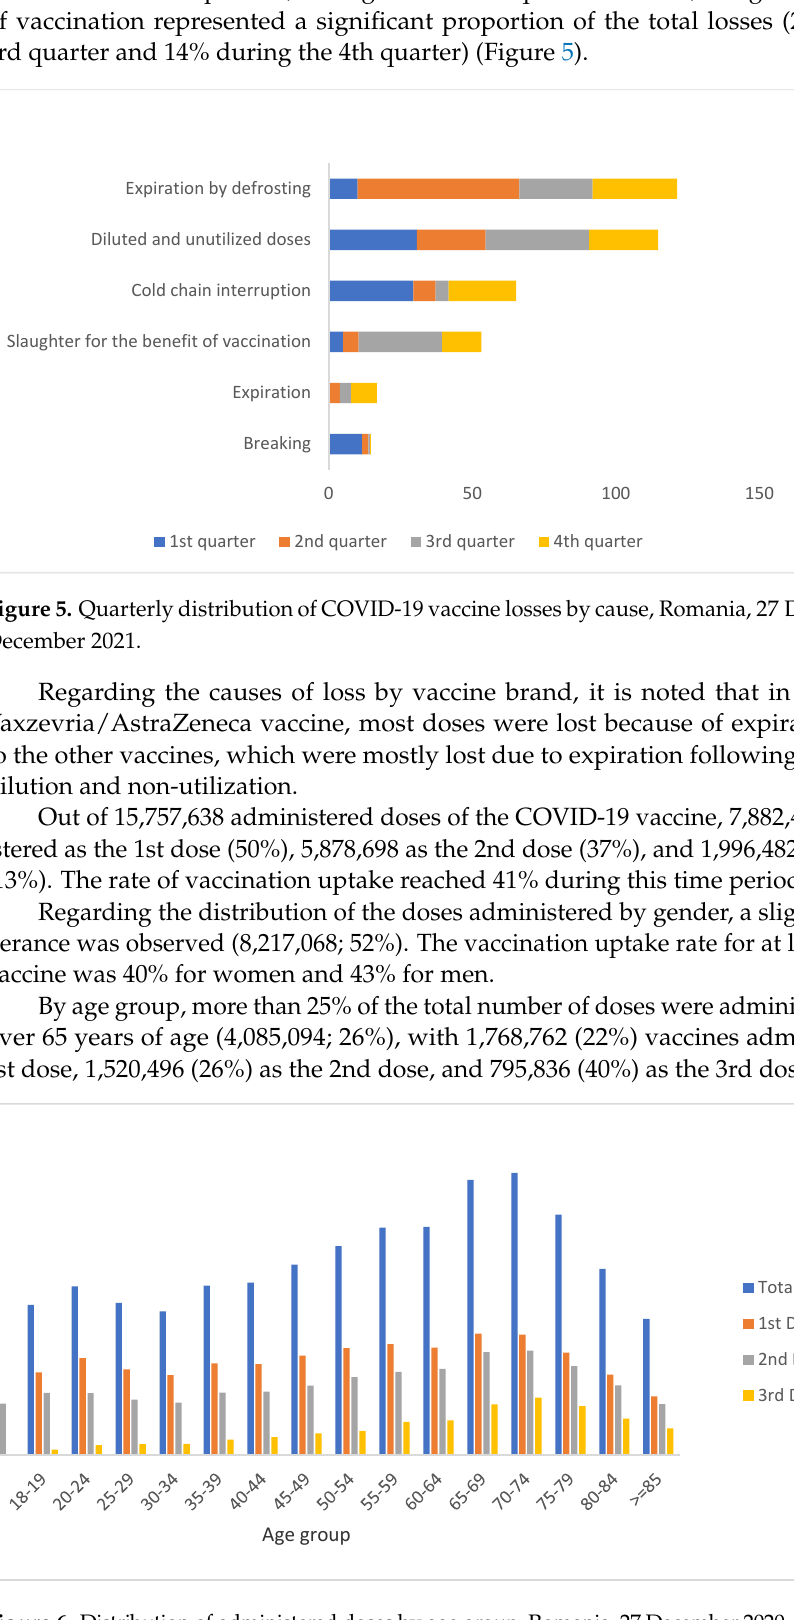
Figure 6. Distribution of administered doses by age group, Romania, 27 December 2020–31 December